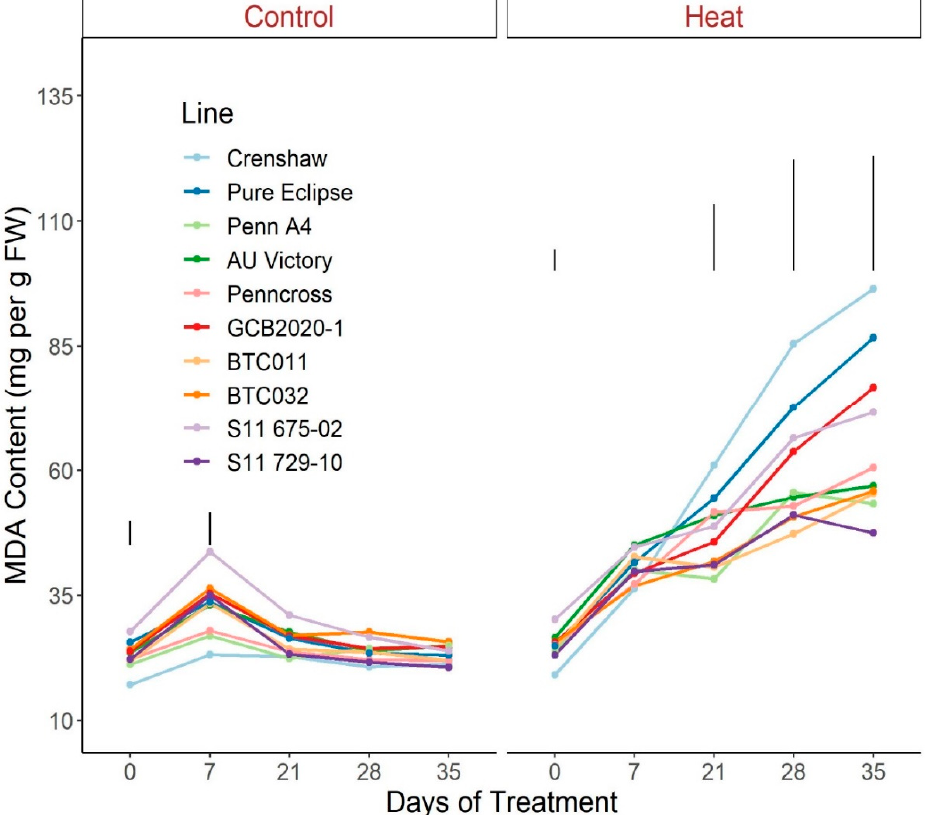
Figure 11. Change in MDA content for creeping bentgrass lines over time under control (20/15 °C day/night) and heat stress (38/33 °C day/night) conditions. Bars represent LSD values at p = 0.05 on days when significant differences among lines were found. FW, fresh weight.